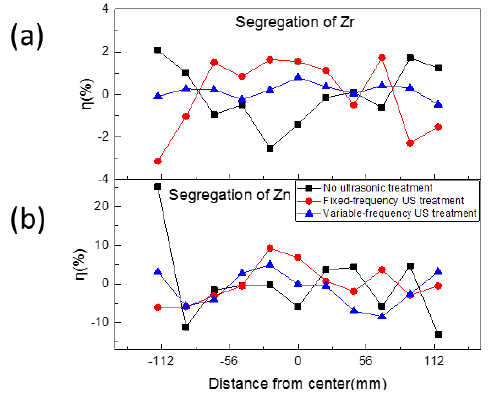
Figure 13. Segregation rate of ZK60 alloy with different ultrasonic treatments: ( a ) Zr; ( b ) Zn.